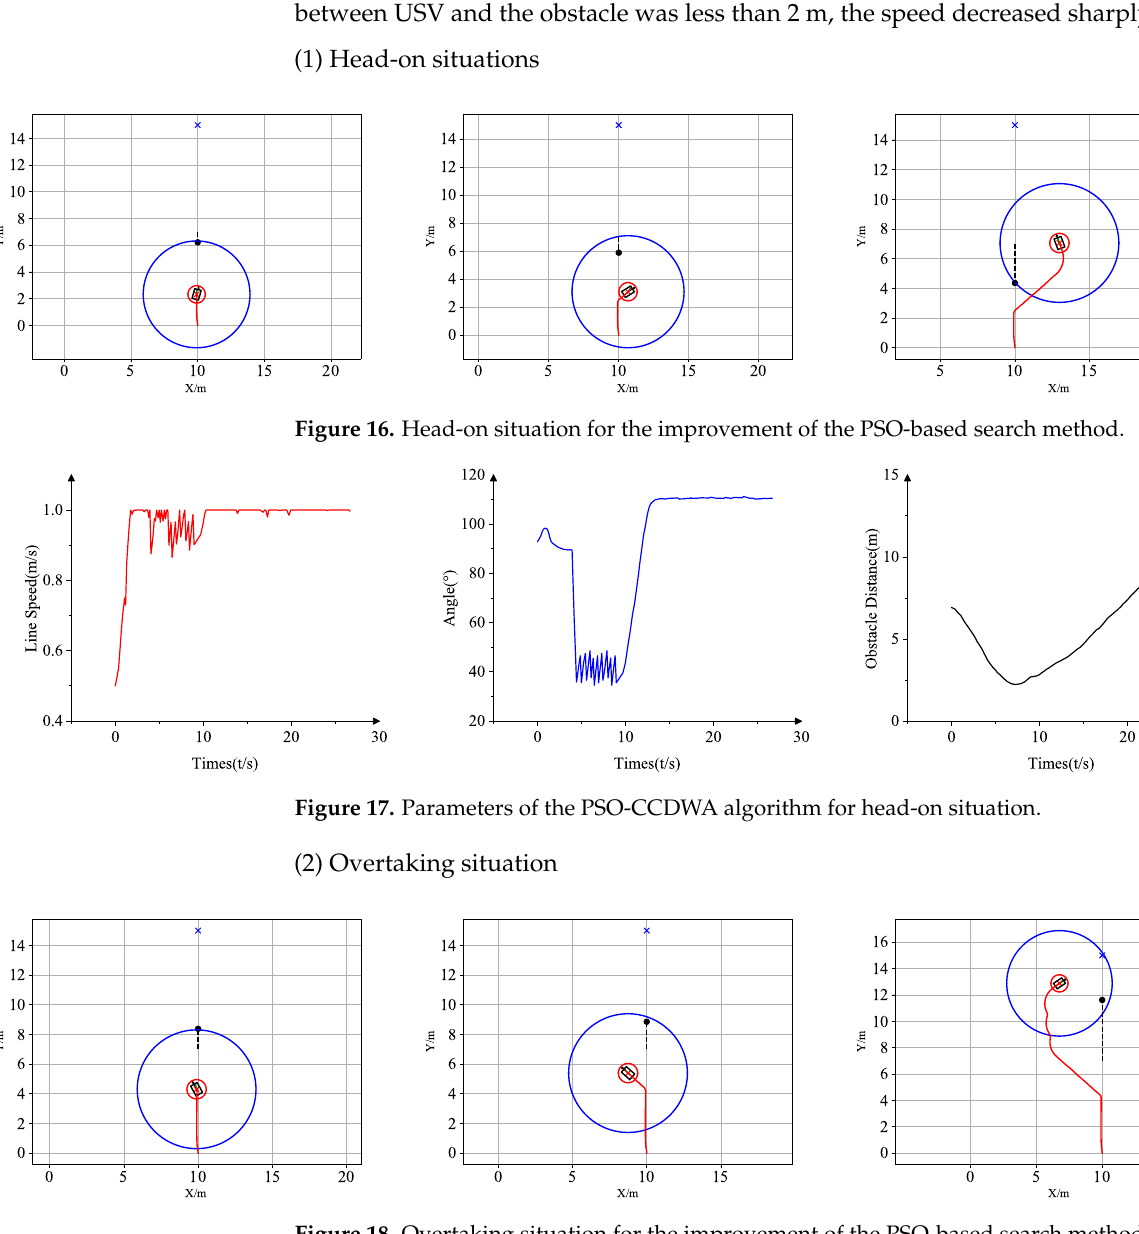
Figure 18. Overtaking situation for the improvement of the PSO-based search